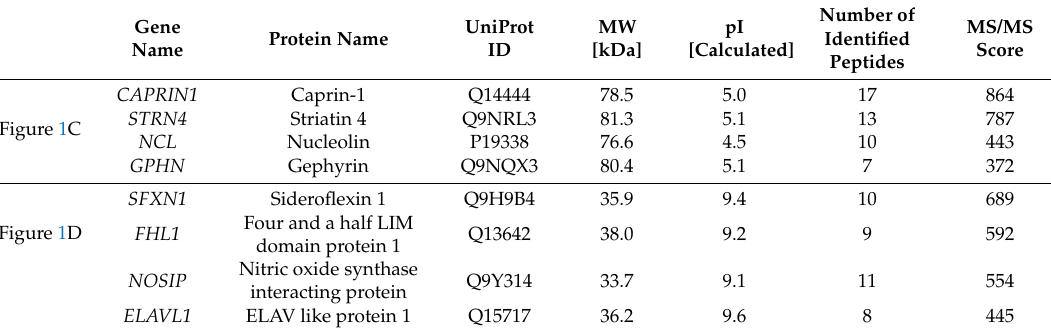
Table 1. Protein assignment of differentially down-regulated protein spots. SM-induced and TRPA1-dependent down-regulated spots were analyzed by nanoHPLC-ESI MS/MS. Peptides were identified by NCBInr protein database search. Molecular weights (MW) were taken from UniProt database and theoretical pI values were calculated using isoelectric point calculators [26,27]. MS/MS scores represent sums over all MS/MS scores of every significant